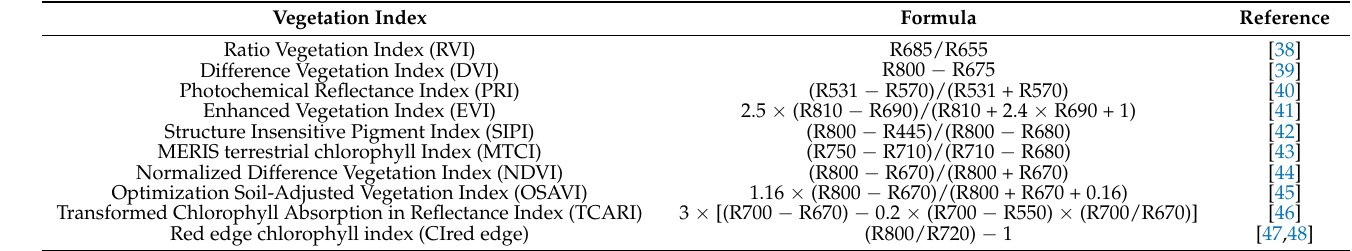
Table 3. Vegetation index calculation